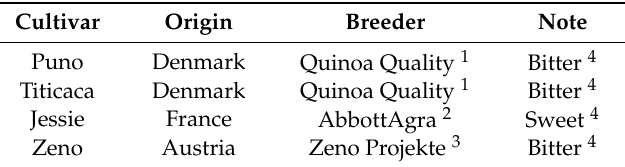
Table 1. Characteristics of the tested quinoa cultivars.